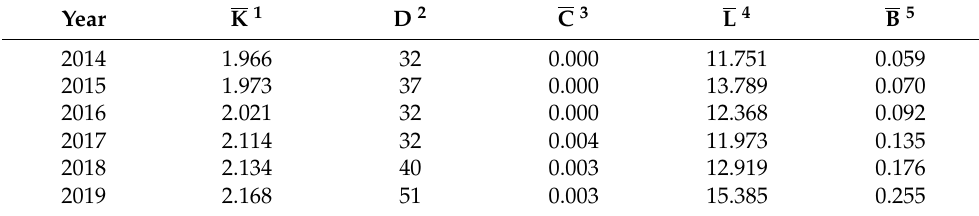
Table 3. Evolution of topological statistics indexes of Wuhan rail